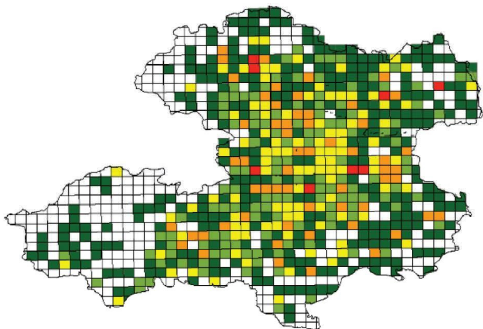
Figure 15: Distribution of residential district.